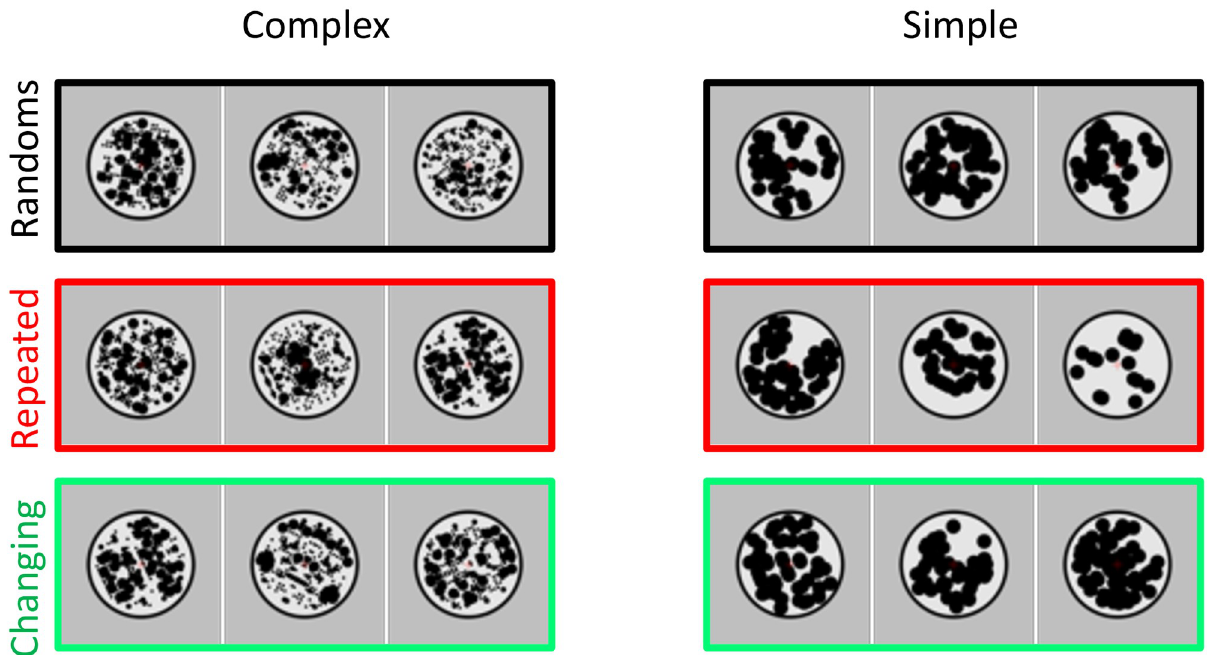
Fig 7. Experiment 3 stimuli. 24 participants were presented with complex patterns (left column) and another 24 were presented with simple patterns (right column).